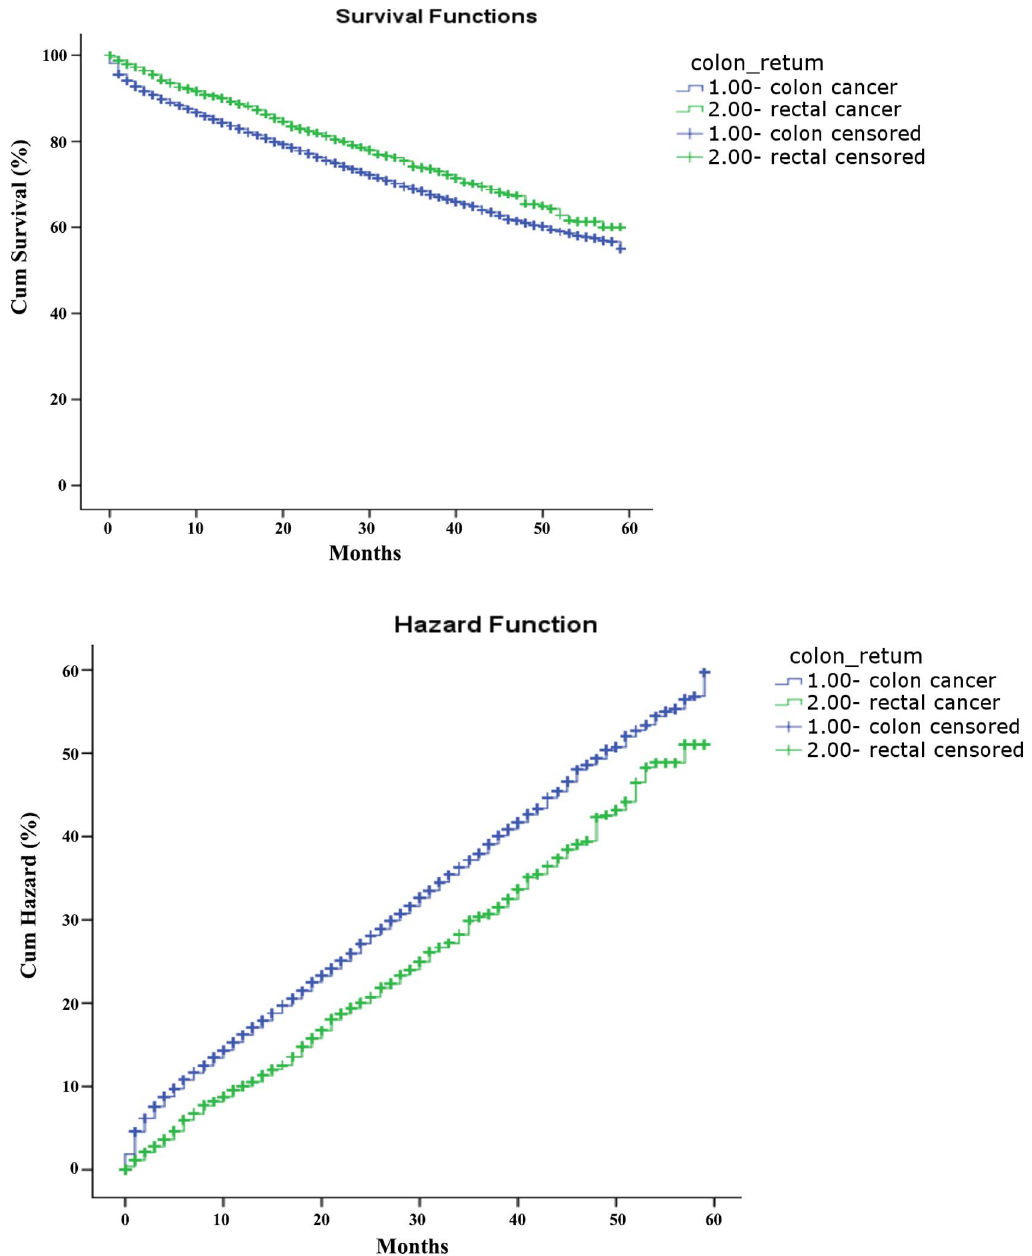
Figure 3. Survival and cumulative hazard of stage IIIB colon and rectal cancer patients (1, colon cancer; 2, rectal cancer).